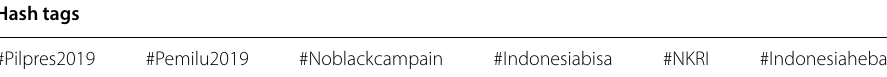
Table 1 Some hashtags related to Presidential election in